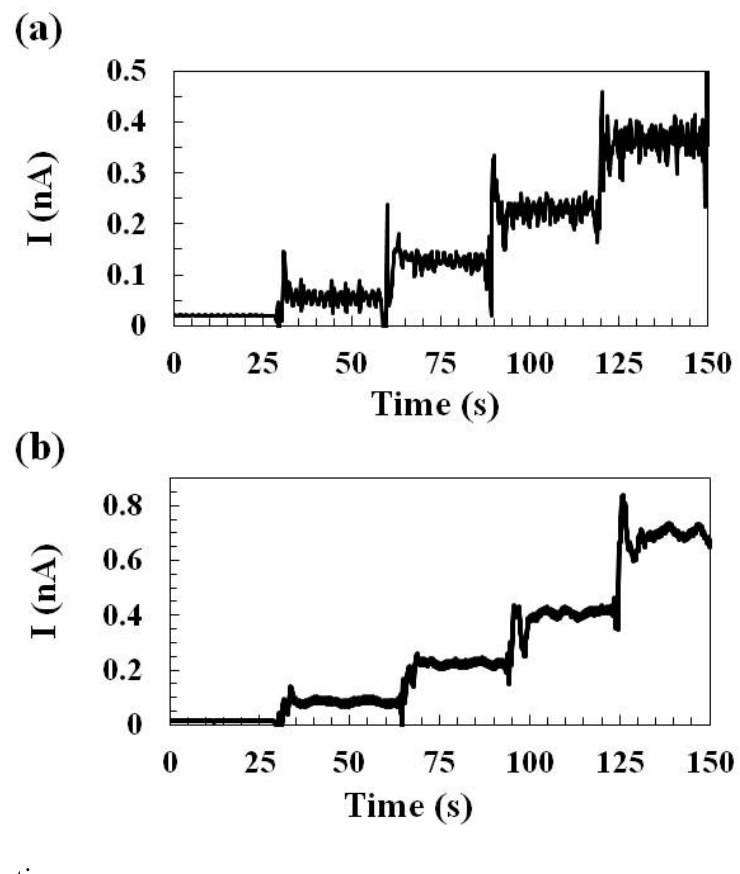
Figure 1. Representative glutamate sensing current responses of sensors prepared by ( a ) Method 1 and ( b ) Method 2 . The sensors were tested with different concentrations of glutamate from 0 μ M, 20 μ M, 60 μ M, 119 μ M, to 217 μ M during which a constant oxidation potential 0.7 V vs. Ag/AgCl was